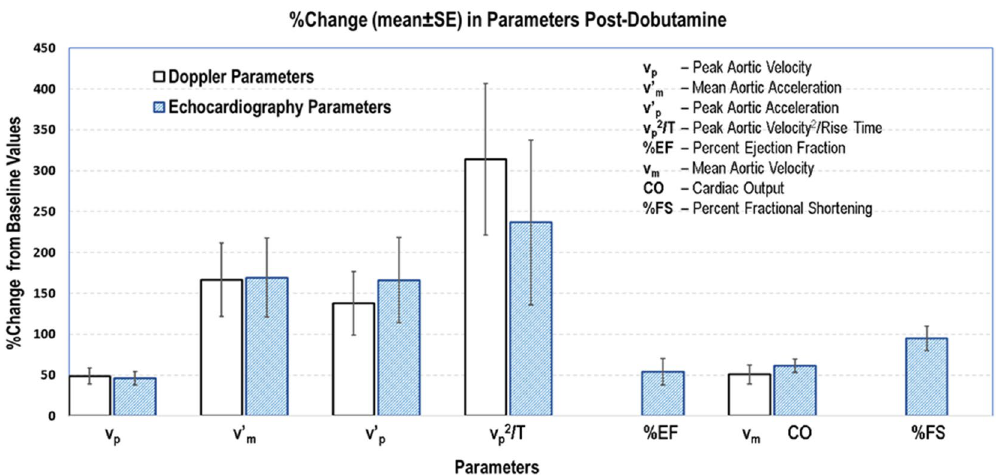
Figure 7. Percent changes in Doppler (DFVS) and Echocardiography (VEVO770) parameters of group 2 mice induced by administration of dobutamine. All dobutamine induced changes were significantly higher regardless of the method used to measure.